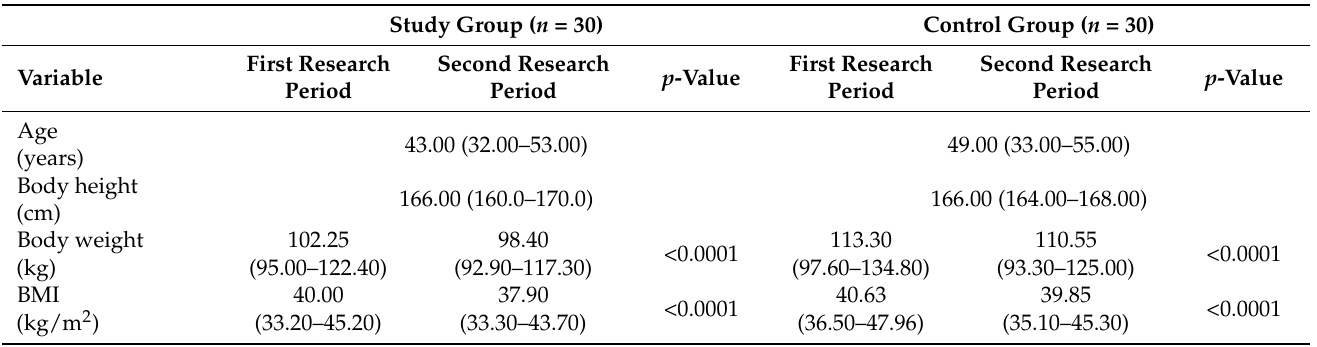
Table 1. The effect of exercises with oxygen supplementation on the anthropometric characteristics (Me (Q1–Q3)) in obese patients.